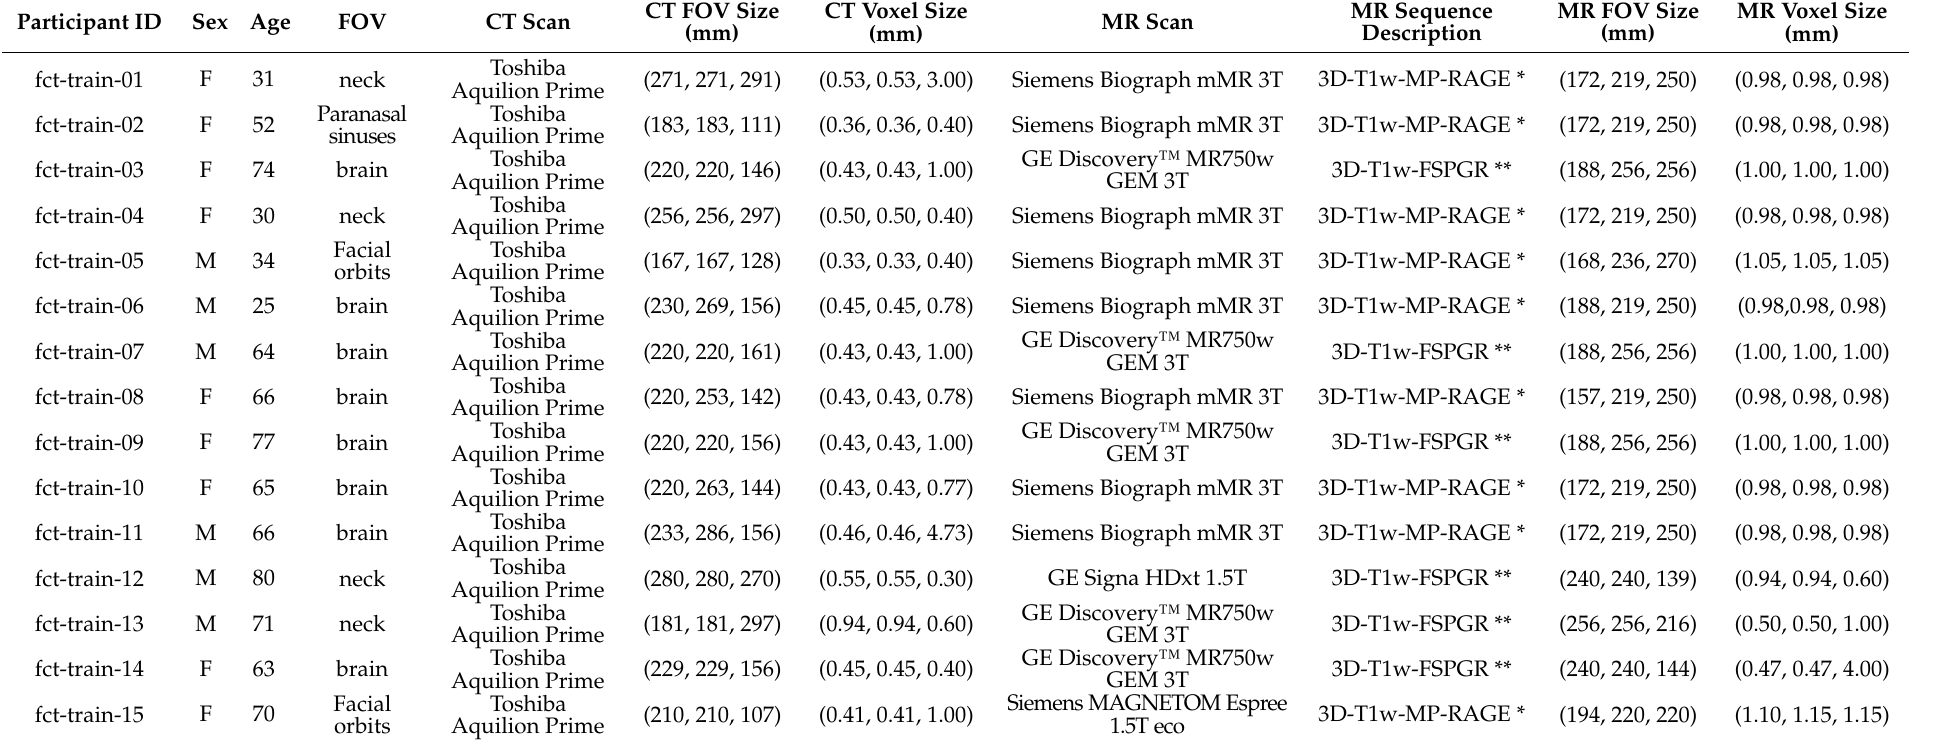
Table A1. Extended demographic and technical details from patients included in training